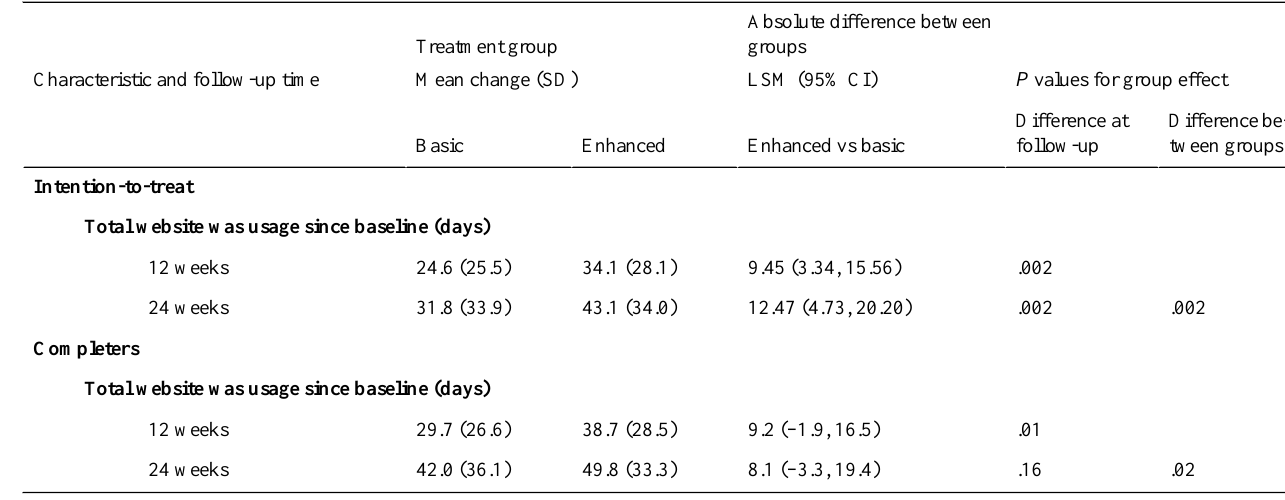
Mean change (SD)Characteristic and follow-up time